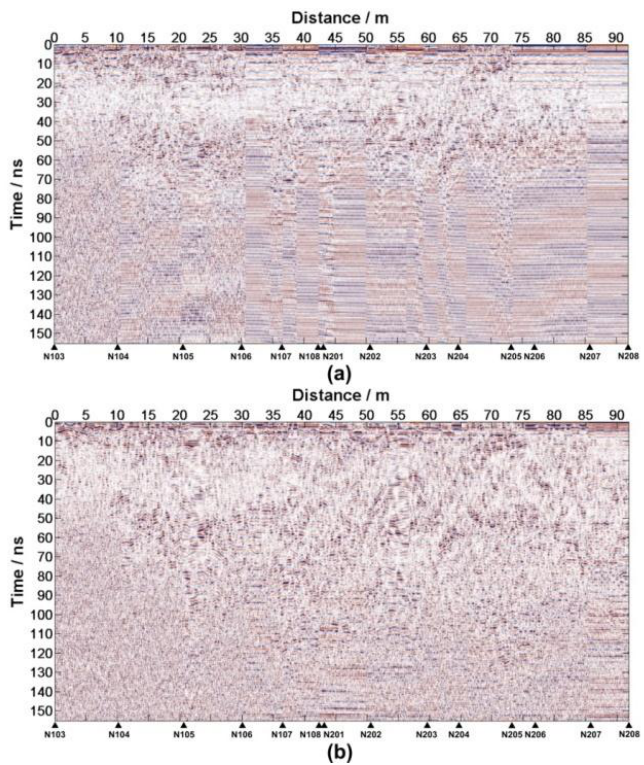
Figure 12. ( a ) The LPR CH-2A image and ( b ) The LPR CH-2B data image. N103-N209 denote the positions where the LPR was rebooted.